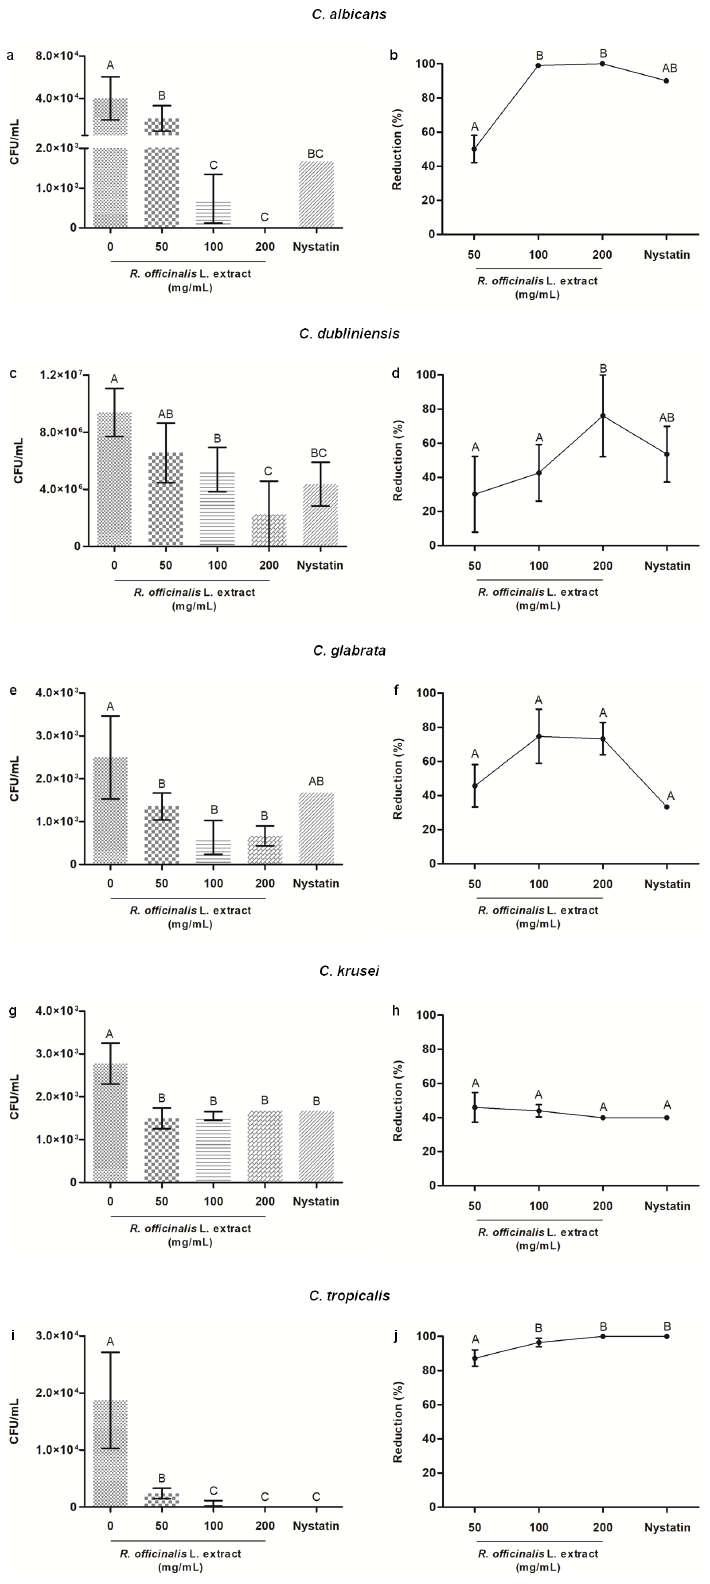
Figure 2. Mean values (± standard deviation) of CFU/mL and reduction percentage (%) of the biofilms of C. albicans (a,b), C. dubliniensis (c,d), C. glabrata (e,f), C. krusei (g,h), and C. tropicalis (i,j) obtained after 5 min exposure to the R. officinalis L. extract (50, 100, and 200 mg/ mL) or to the nystatin (100,000 IU/ mL), compared to the control group (0 mg/mL – 0.9% NaCl). Different letters indicate significant statistical difference. ( n = 10; One-way ANOVA and Tukey’s test; P ≤